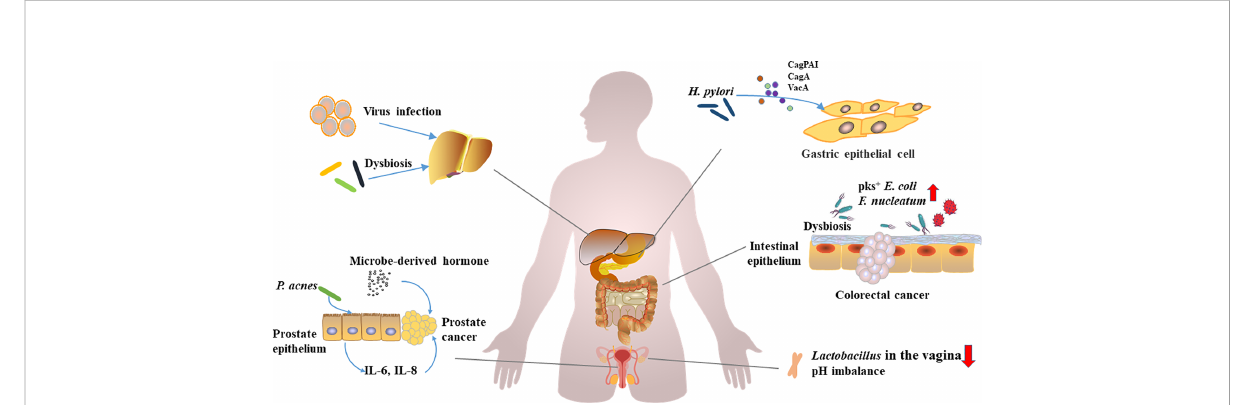
FIGURE 1 Carcinogenic microorganism infections, microbial disorders, and carcinogenesis.Viruses, oncogenic microorganisms infections, and dysbiosis of the microbiota have been implicated in the development of multiorgan cancers. H. pylori promotes gastric carcinogenesis through virulence factors (CagPAI, CagA, and VacA etc.). F. nucleatum and pks + E. coli can promote the development of colorectal cancer. Lactobacillus , a vagina- dominant genus that helps regulate pH, is reduced in abundance in ovarian cancer patients. P. acnes induces prostate cancer by stimulating the production of IL-6 and IL-8 in prostate cells, and hormones derived from microorganisms promote the development of prostate cancer. Hepatitis virus induces hepatitis, and persistent in fl ammation and dysbiosis can affect the occurrence of liver